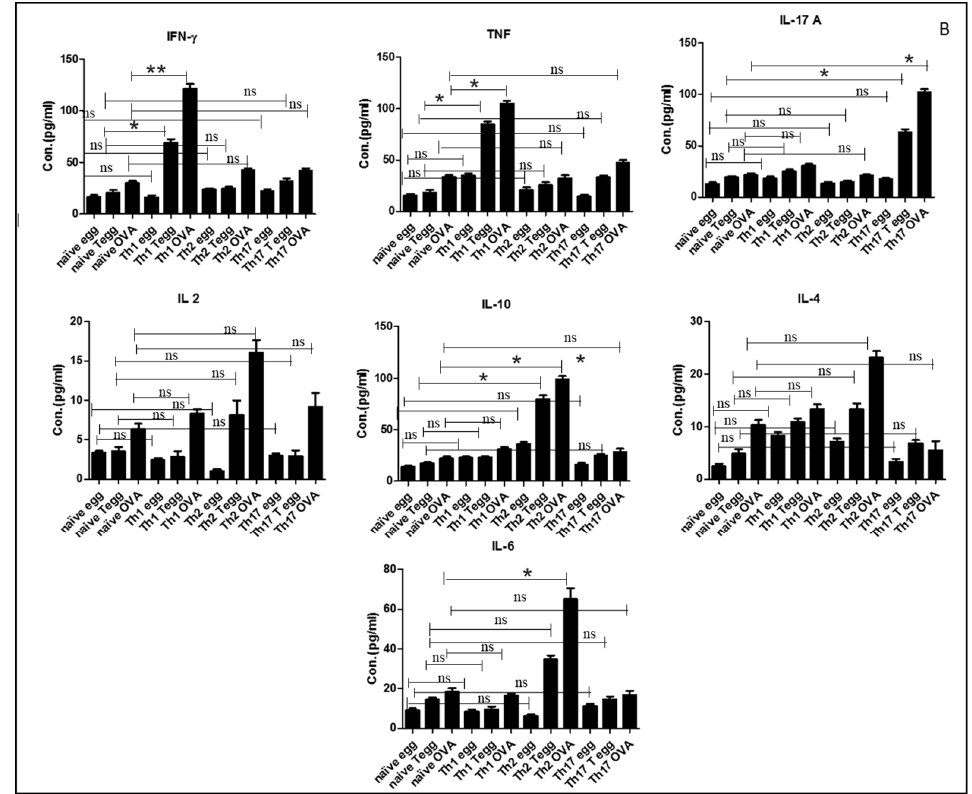
Figure 4. Th cytokines produced by Th-polarized memory T cells after infection with OVA expressing eggs and followed by ex vivo re-stimulation. After in vitro differentiation of naïve OT-II T cells into Th1, Th2, and Th17 cells, memory cells were further produced using IL-7 and a total of 2 × 10 6 polarized memory T cells were transferred into each congenic mice (CD45.1, n = 6, I.V.). After two days, each congenic mouse was challenged with OVA-expressing eggs, OVA protein (30 μ g OVA), and wild type eggs as a positive and negative control, respectively. After seven days, mice were culled to extract memory OT-II T cells and restimulated with OVA protein (20 μ g OVA) ( A ) and finally, culture supernatants were analysed for detection of signature cytokines using cytometric bead array ( B ). Single * ( p < 0.05) and double ** ( p < 0.01) in the graph represents the value statistical association among the dependent and independent variables and “ns” represents no statistical significance. The experiment in this study were performed in triplicates and the statistical association between different dependent and independent variables was analysed using a t -test.